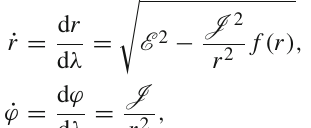
Fig. 5 Continuous distributions of redshift z in the direct images cast by the accretion disk in Schwarzschild-MOG spacetime under different values of parameter α and inclination angles. The red corresponds to the maximum value of the redshift, while the minimum value is rep-